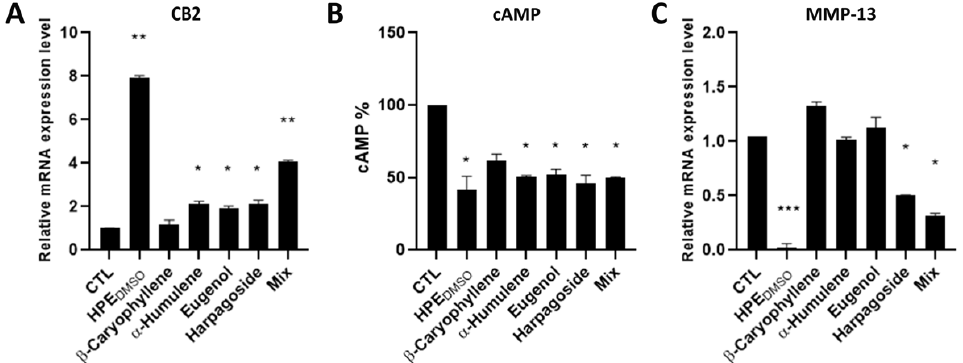
Figure 7. Effects of HPE DMSO on CB2, cAMP and MMP-13 production. Cells were treated with 0.1 mg/mL HPE DMSO , 8 ng/mL β -caryophyllene, 2 ng/mL α -humulene, 0.4 ng/mL eugenol and 0.4 µ g/mL harpagoside and with the mixture of all four compounds (Mix) at same concentration, for 24 h. After treatment, the mRNA was extracted and analyzed by RT-PCR. CB2 ( A ) and MMP-13 ( C ) mRNA level was reported as relative mRNA expression level with respect to 18S mRNA (2 − ∆∆ Ct method); The cAMP ( B ) amount was measured by cAMP ELISA kit. Results are expressed as mean ± SEM of data obtained by three independent experiments. * p < 0.05; ** p < 0.01; *** p < 0.005 vs. CTL.